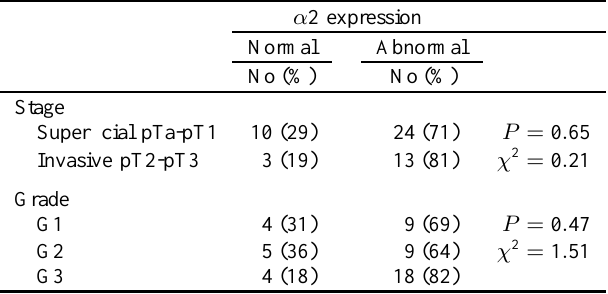
Table 1 Relationships of (cid:11) 2 integrin expression to histopathological data